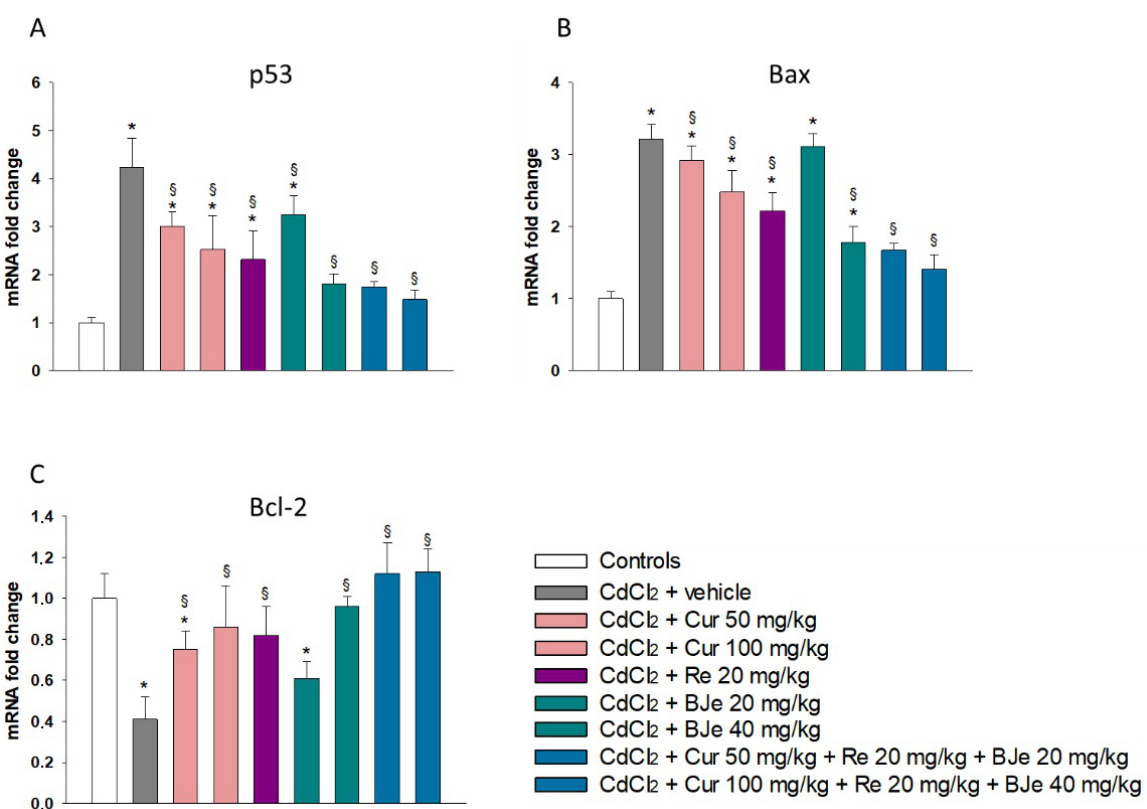
Figure 2. Real-time PCR analysis for p53 ( A ), Bcl-2 ( B ), and BAX ( C ). * p < 0.05 versus control mice; § p < 0.05 versus CdCl 2 -treated